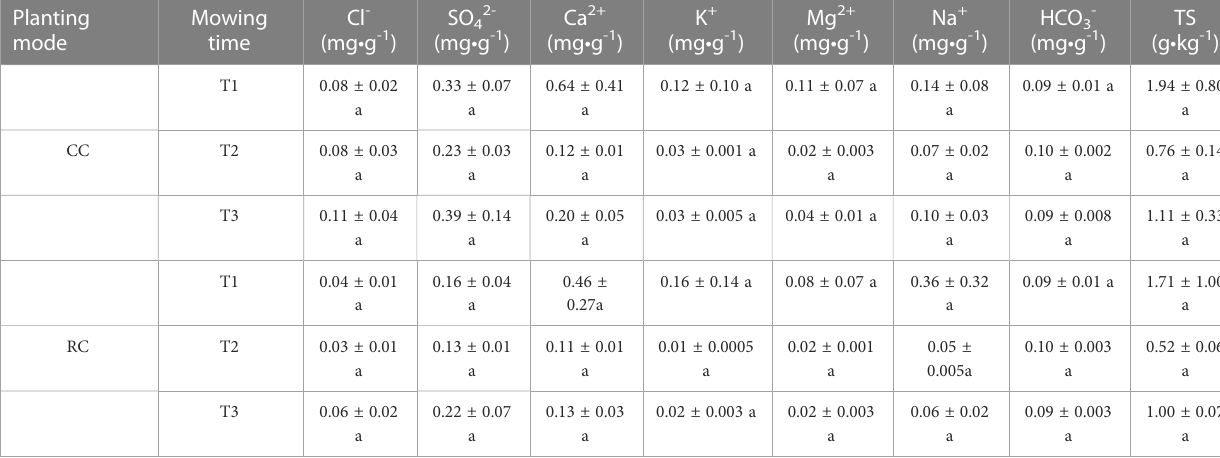
TABLE 3 saltiness of soil. Planting mode